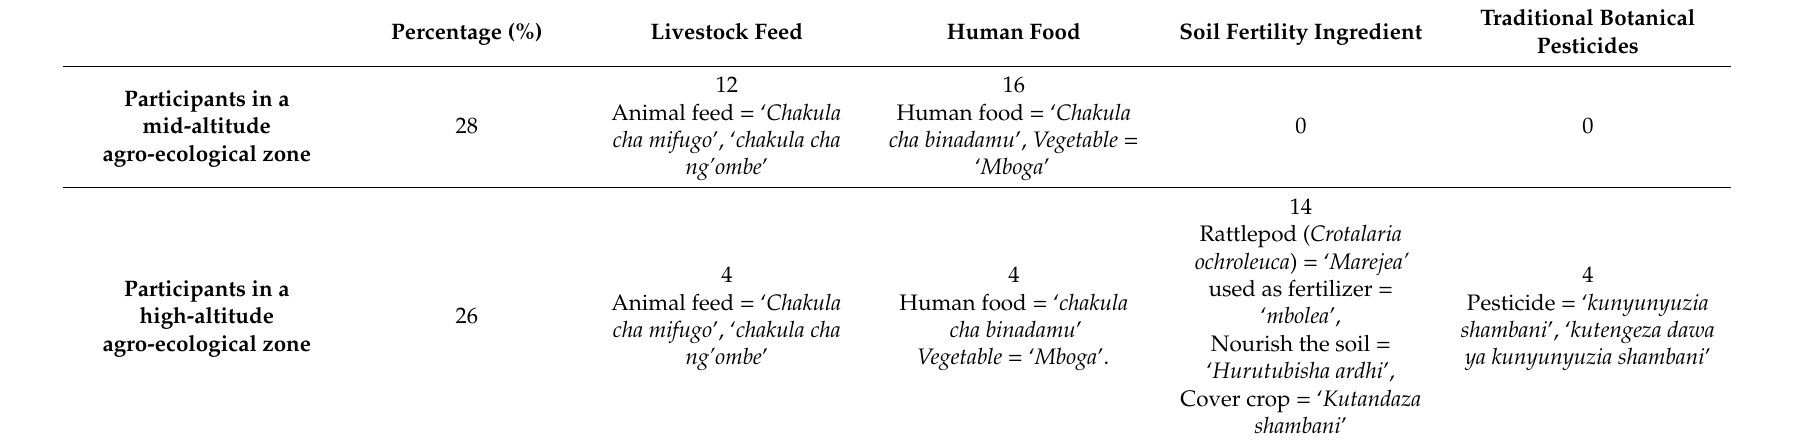
Table 3. Wild legumes uses as known by participants with prior knowledge of wild legumes. * Percentage